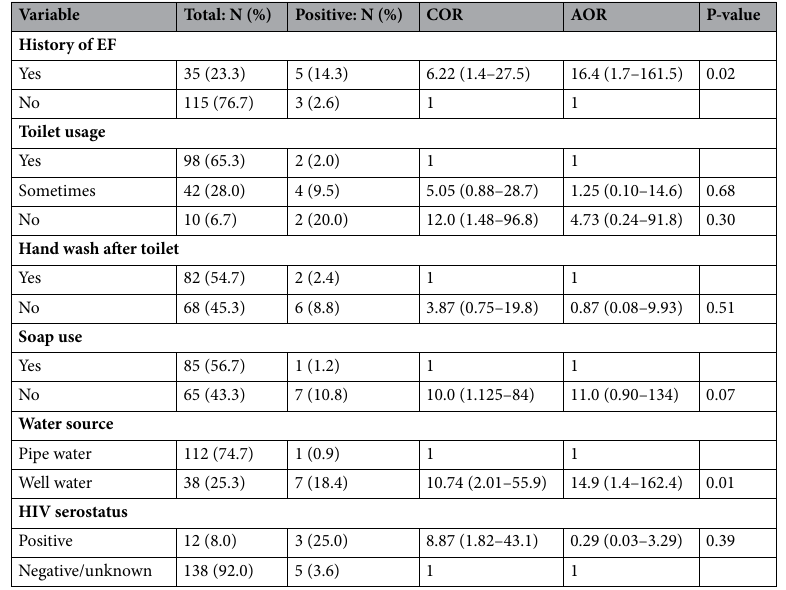
Table 3. Factors associated with prevalence of enteric fever among febrile patients (n = 150) at FHCSH, Bahir Dar, Northwest Ethiopia, 2020. EF enteric fever.